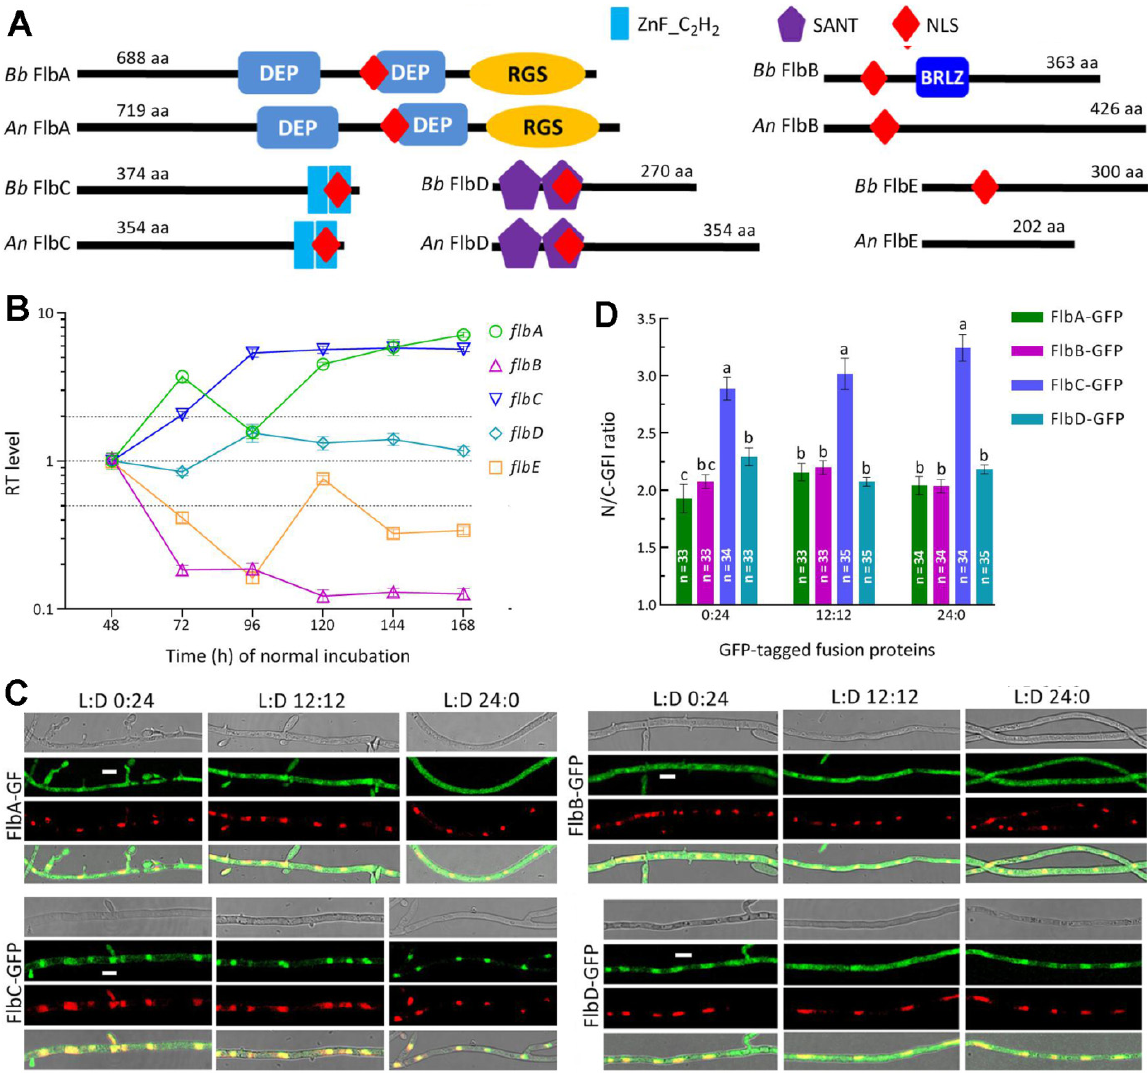
Figure 1. Sequence, transcription and subcellular features of FlbA–FlbE in B. bassiana . ( A ) Sequence comparison of FlbA–FlbE between B. bassiana ( Bb ) and A. nidulans ( An ). Domains and nuclear localization signal (NLS) were predicted from each protein sequence at http://smart.embl-heidelberg. de/ (accessed on 20 March 2022) and http://nls-mapper.iab.keio.ac.jp/ (accessed on 20 March 2022), respectively. ( B ) Relative transcript (RT) levels of flbA–flbE in the SDAY cultures of wild-type Bb strain (WT) during a 7-d incubation at the optimal regime of 25 ◦ C in a light/dark (L:D) cycle of